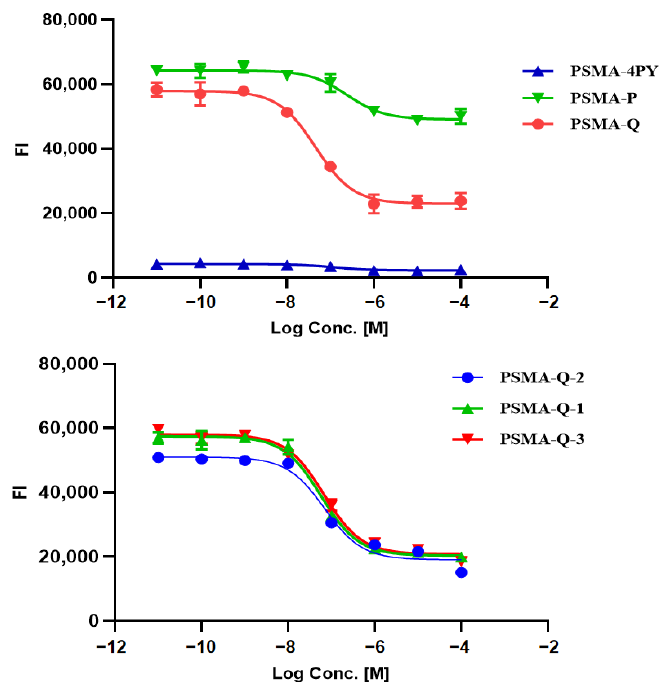
Figure 3. Determination of the binding affinity of novel PSMA ligands by enzyme-based assay (FI = fluorescence intensity).